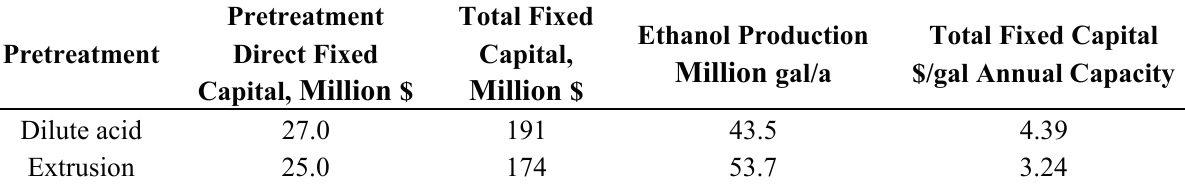
Table 3. Capital cost for each pretreatment technology [43].